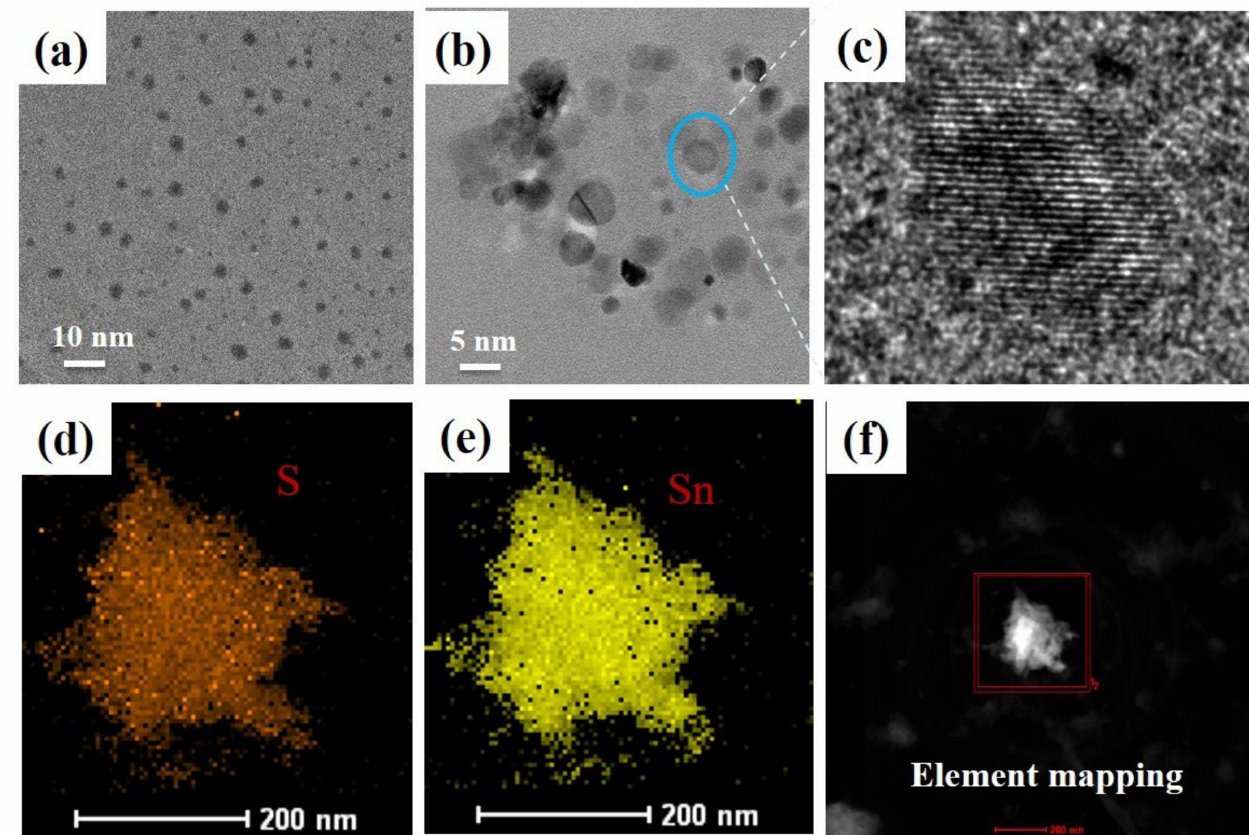
Figure 1. Morphology of SnS 2 nanoparticles quantum dots measured by transmission electron scope (TEM) ( a , b ), high resolution TEM ( c ), and element mapping ( d – f